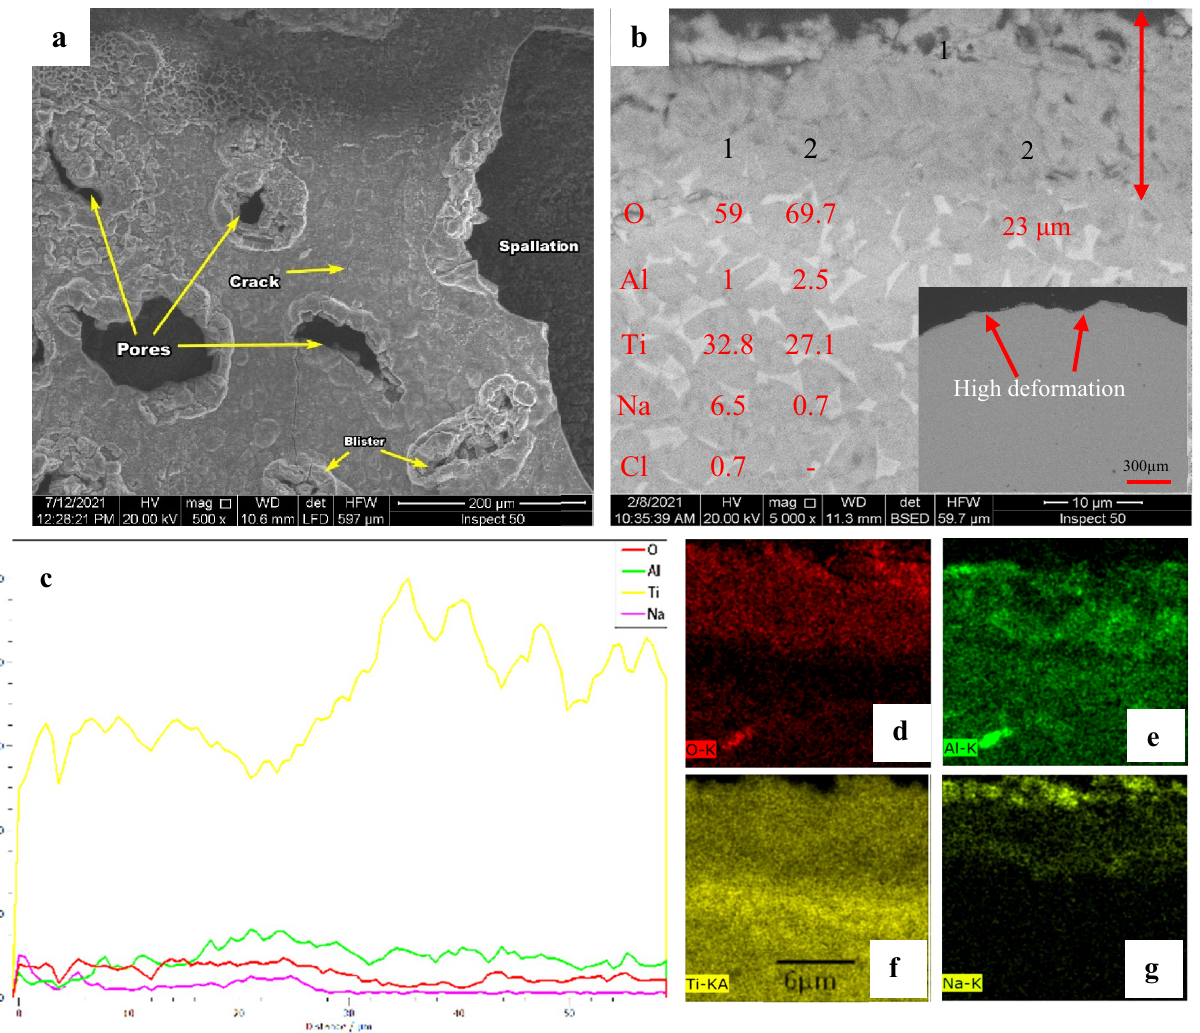
Figure 14. SEM and EDS for raw specimens after exposure to hot corrosion ( a ) surface morphology, ( b ) cross- section, ( c ) line element distribution, and ( d – g ) element map